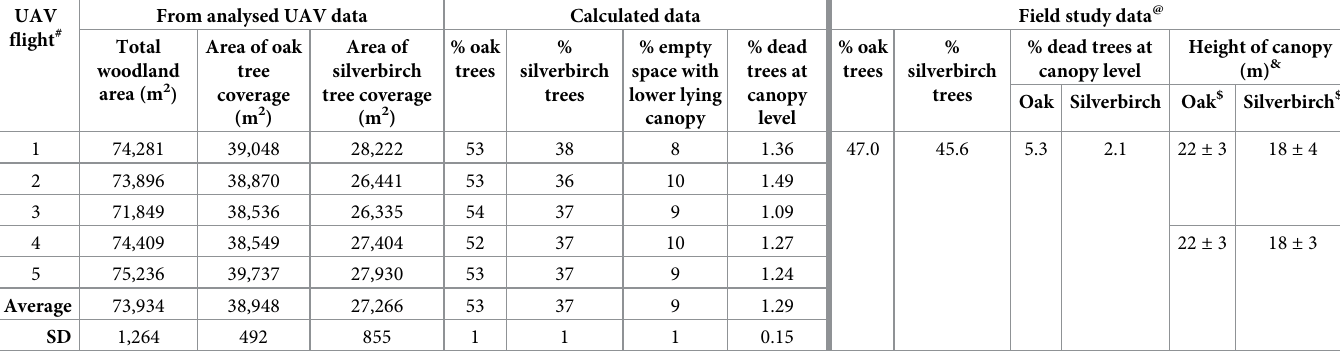
Table 2. Quantitative information obtained by analysis of UAV MSI and field study